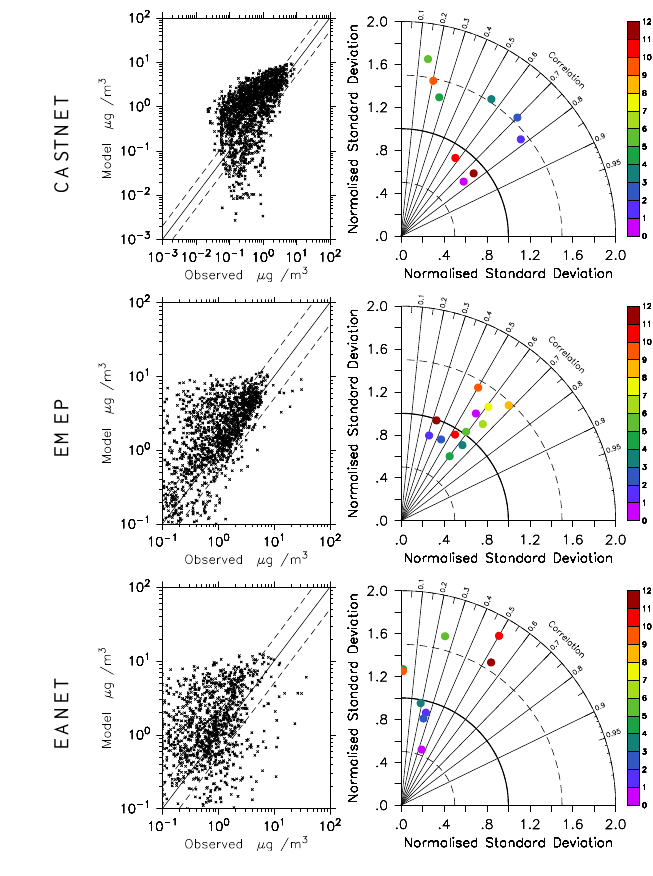
Fig. 6. Left: scatter plots of observed and modelled monthly aver- aged concentrations (in µgm − 3 ) for the year 2005–2008 of SO 2 − Right: Taylor diagram of the comparison between station observa- tions and model results. The color code denotes the month of the year for which the statistical values are calculated. Upper: obser- vations from CASTNET, middle: observations from EMEP, lower: observations from EANET.